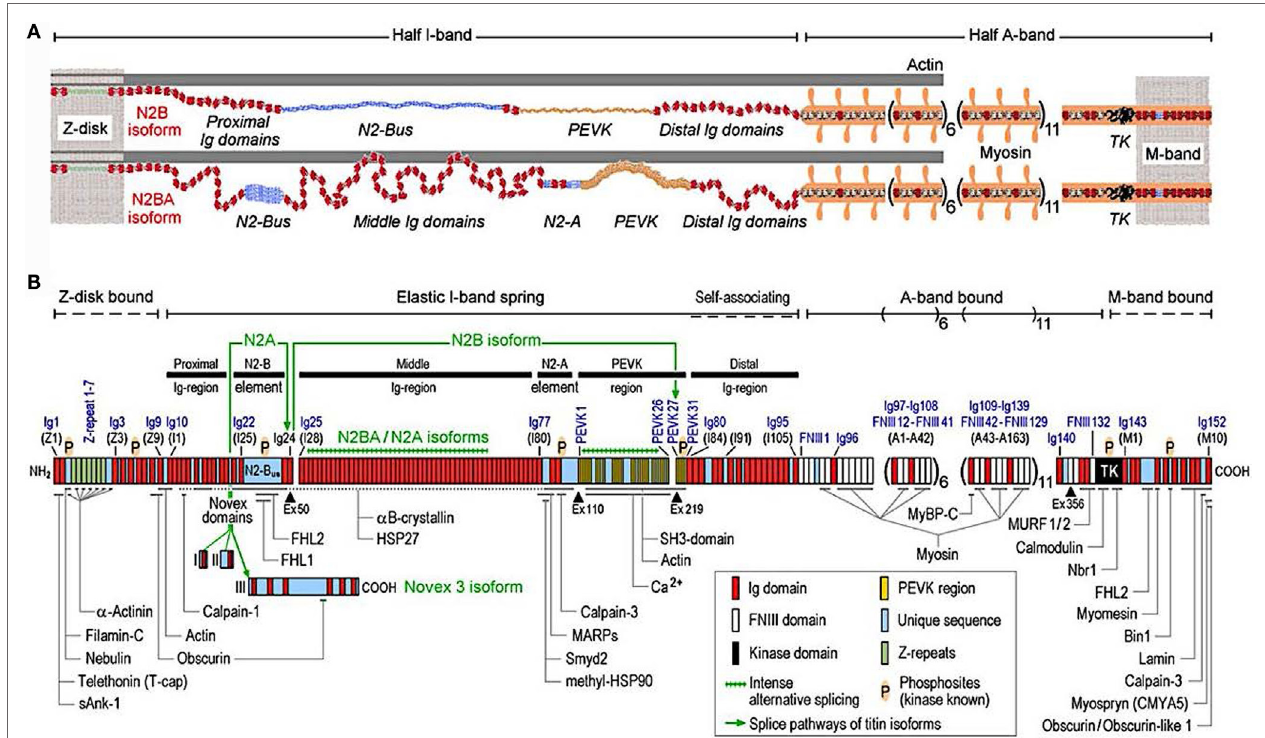
FiGURe 1 | Domain structure of titin isoforms and binding sites of titin ligands . (A) N2B and N2BA titin isoforms represented in the cardiac half-sarcomere, (B) Domain structure of titin sequence, Q8WZ42-1, with ligand binding sites represented (from Linke and Hamdani, with permission) (60).